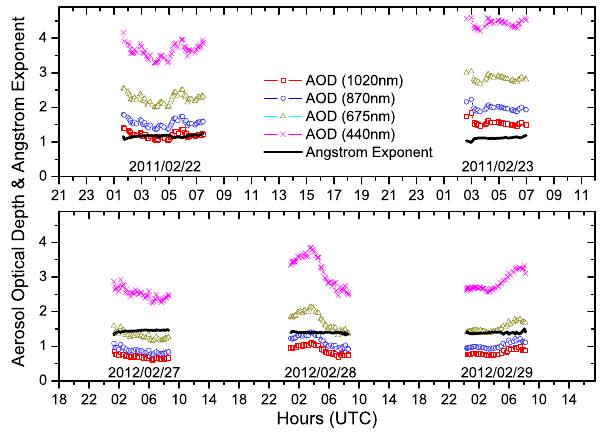
Fig. 1. Time variation of AOD and the Ångström exponent (440–870nm) during two haze events in